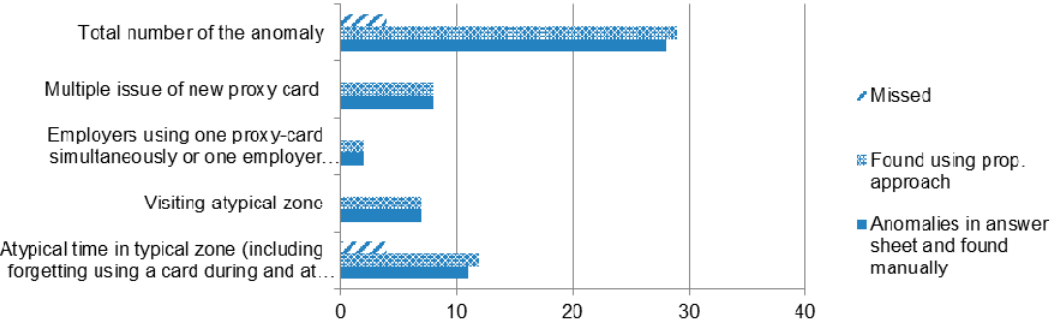
Figure 19. The rate of detected anomalies of different type.